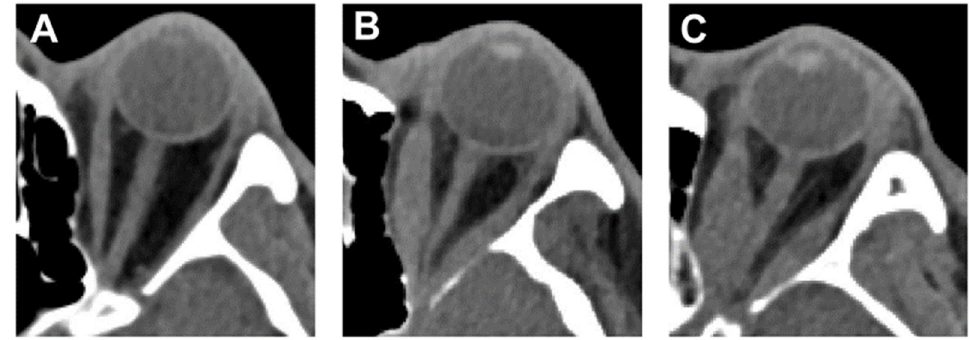
Figure 1. The computed tomography (CT) images of patients with thyroid eye disease (TED) with normal motility (TED-NM) ( A ), non-dysthyroid optic neuropathy (DON) in impaired motility (IM) group (TED-IM-Non-DON) ( B ), and TED-IM-DON ( C ).